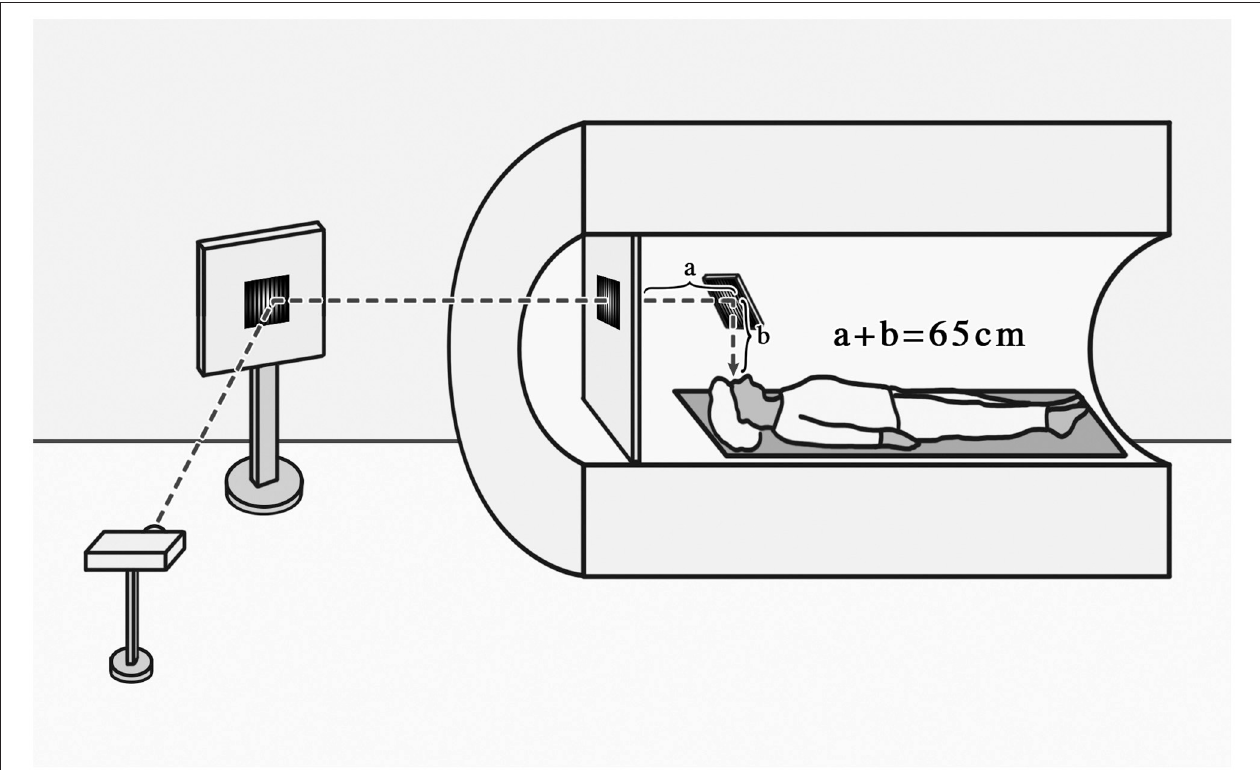
FIGURE 1 | Schematic diagram of the subjects receiving visual tasks.